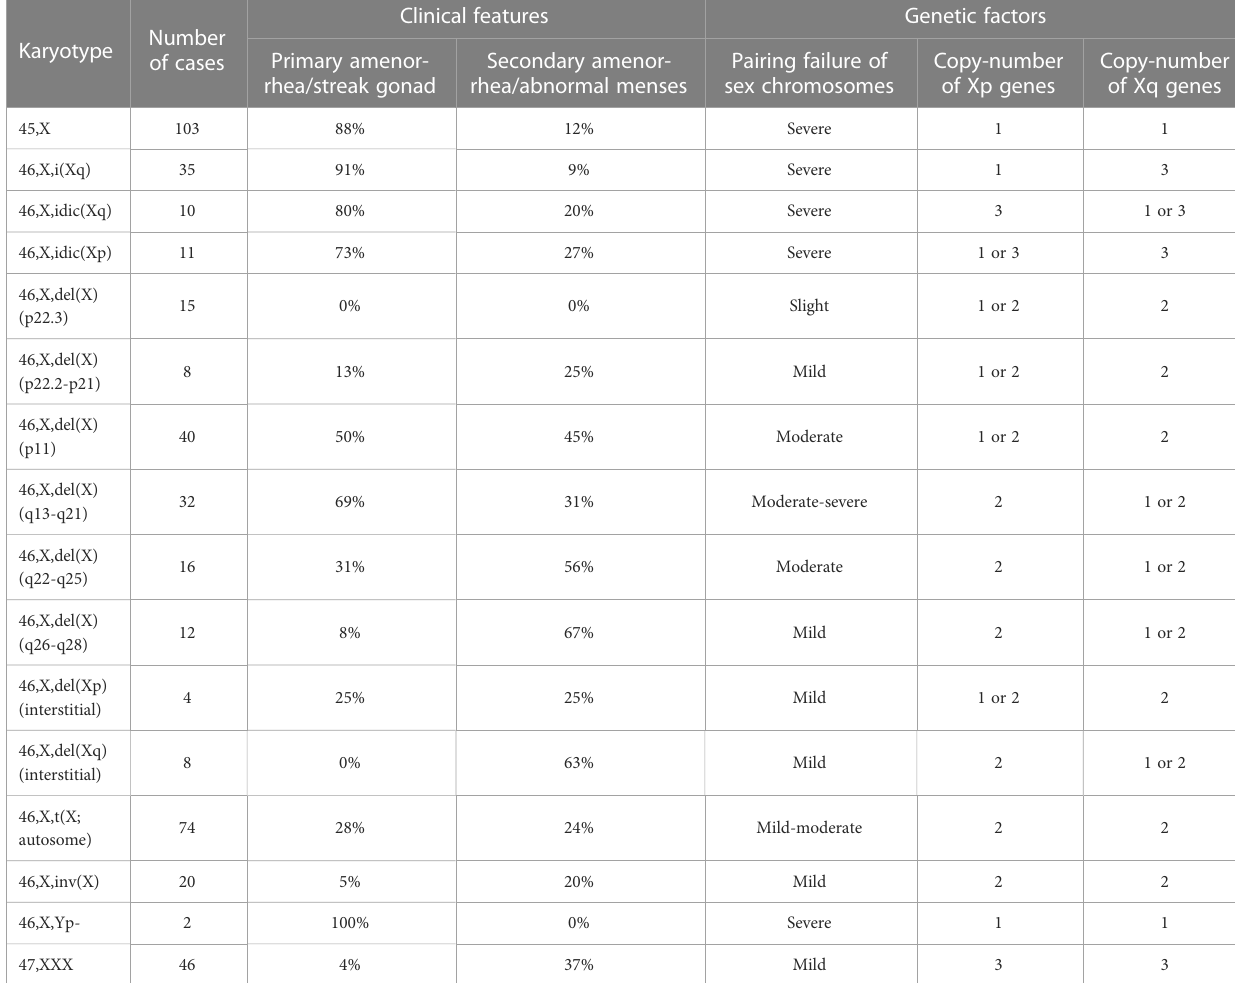
TABLE 1 Review of clinical features and genetic factors of women with 45,X monosomy and non-mosaic X chromosomal structural abnormalities.